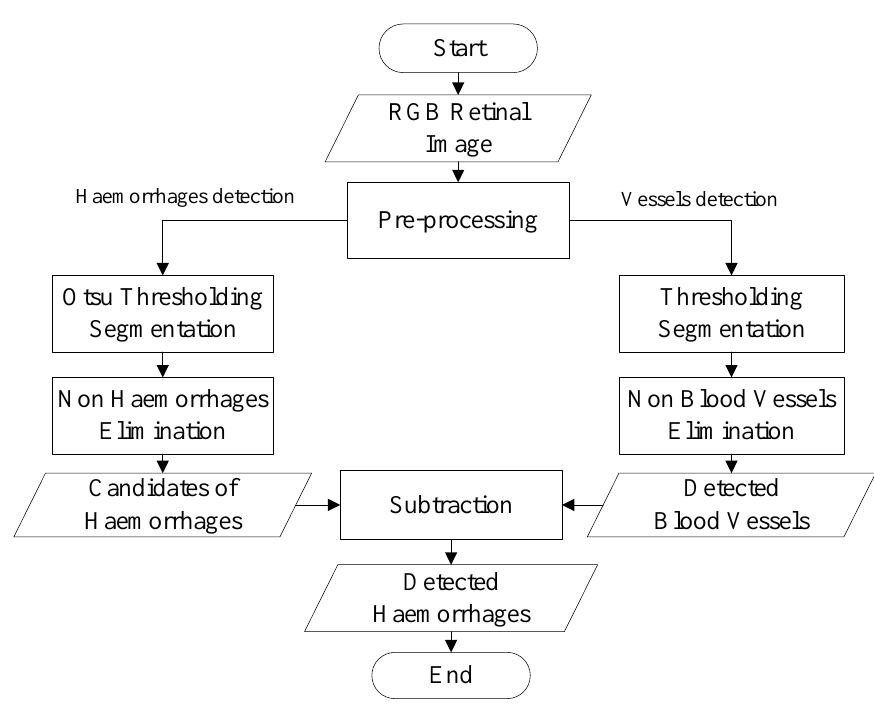
Fig. 2. Flowchart of the proposed